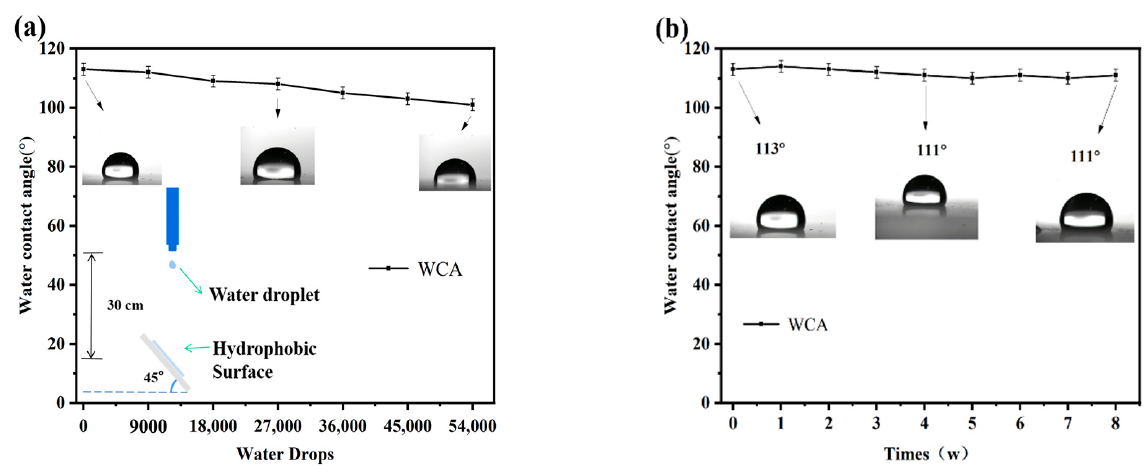
Figure 10. Changes in WCA ( a ) the number of water drops in the free-fall water drop test, ( b ) expo- sure time to air.